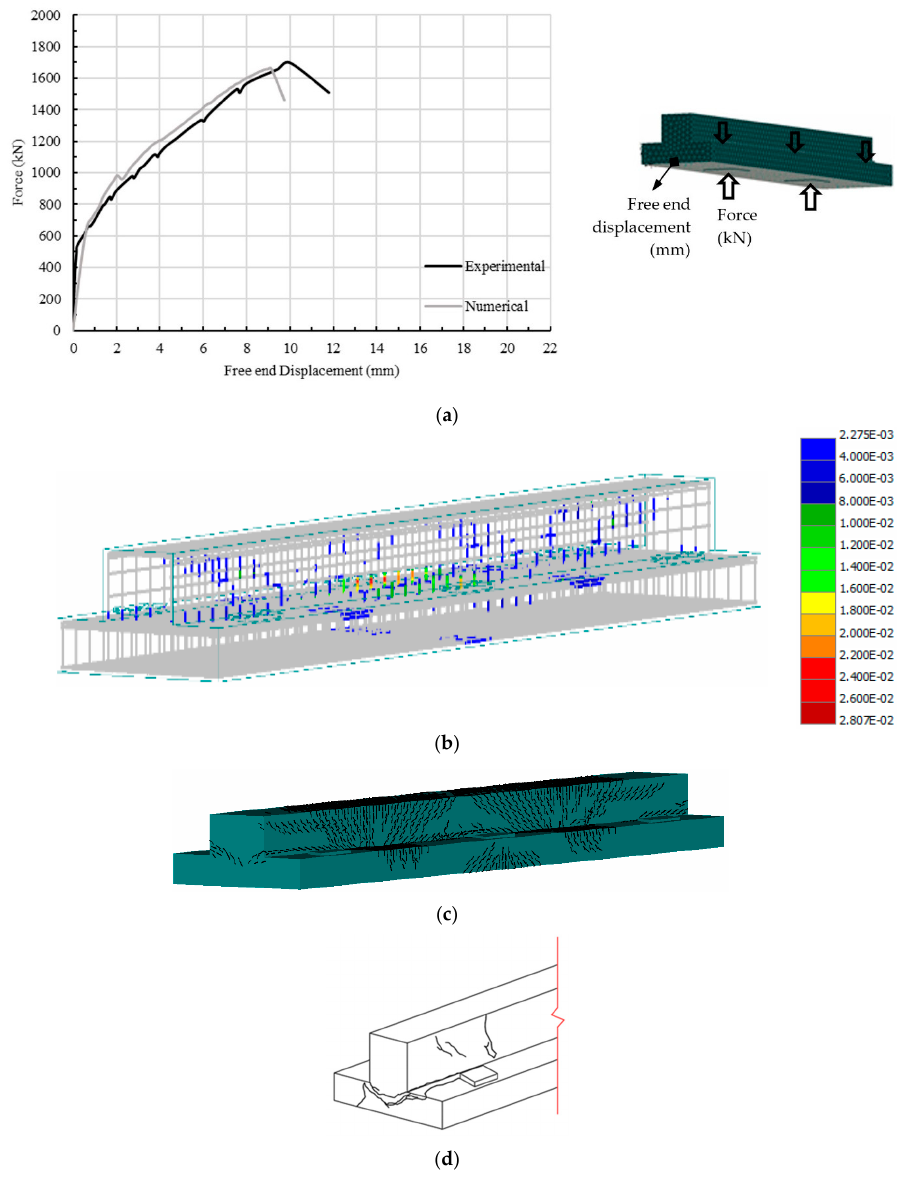
Figure 8. Experimental and numerical responses of specimen ITBC-30-S-2M (30° skew): ( a ) Experimental and numerical force-displacement curves; ( b ) Experimental; ( c ) Crack patterns; ( d ) Test crack pattern [14].